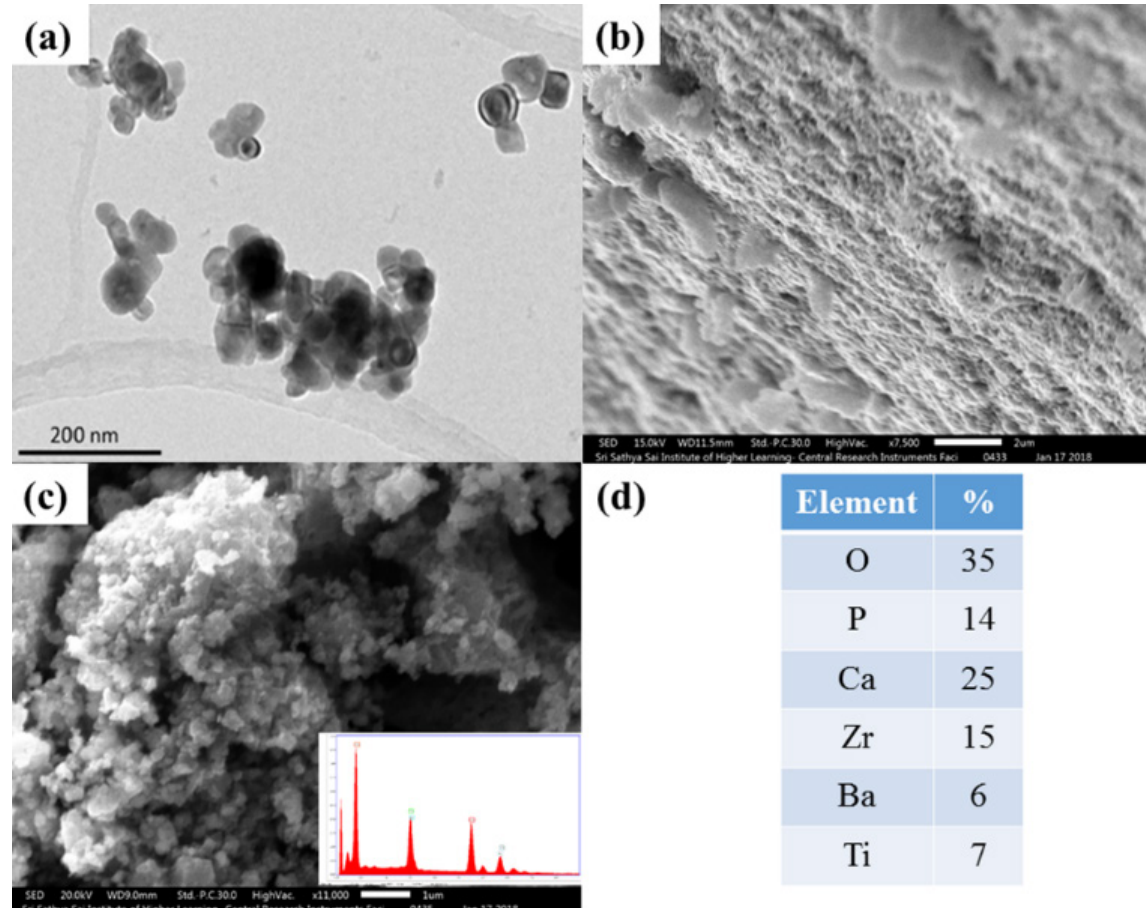
Figure 7: (a) TEM image of Ba 0.85 Ca 0.15 Zr 0.1 Ti 0.9 O 3 ; (b) SEM image of cross-section of 50:50 HA-BCZT at 2 µ m (c) SEM image of the 50:50 HA-BCZT surface at 1 µ m with inset – EDX spectrum; (d) Elemental ratios observed in the HA-BCZT composite as determined by the